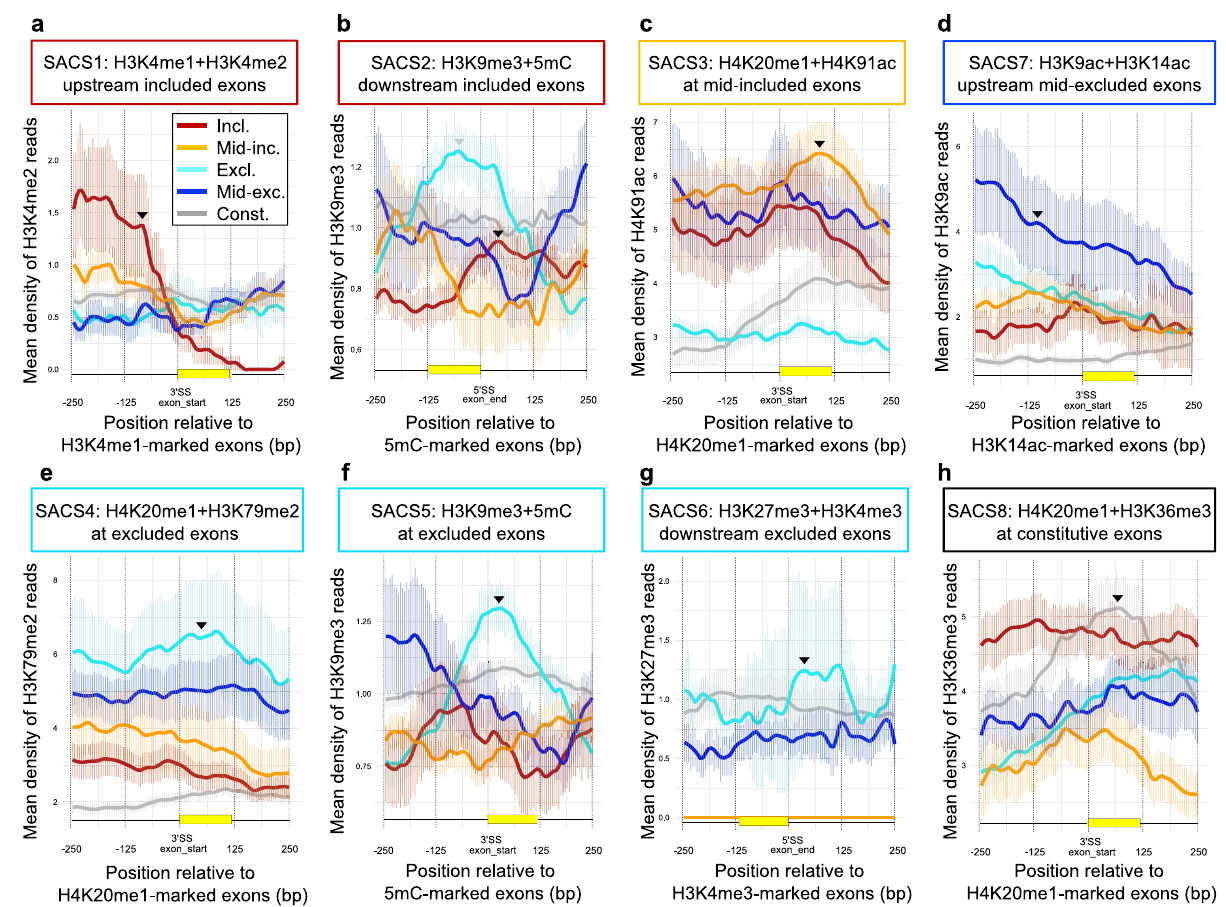
Fig. 3 Pro fi les of Splicing-associated Chromatin Signature (SACS). a Density pro fi les of H3K4me2 reads around exons marked by H3K4me1 upstream the 3 ’ ss exon start. b H3K9me3 reads around exons marked by 5mC downstream the 5 ’ ss end of the exon. c H4K91ac reads around H4K20me1-marked exons. d H3K9ac reads around exons marked by H3K14ac upstream the exon start. e H3K79me2 reads around H4K20me1-marked exons. f H3K9me3 reads around 5mC-marked exons. g H3K27me3 reads around exons marked by H3K4me3 downstream the end of the exon. h H3K36me3 reads around H4K20me1-marked exons in excluded (excl., light blue), mid-excluded (mid-exc., dark blue), mid-included (mid-inc., yellow), included (incl., red) and constitutive (const., grey) exons using available ChIP-seq datasets from H1 hESCs. The average read count and ±SEM of histone marks ’ reads is represented ±250 bp from either the 5 ′ or 3 ′ splice site (ss), depending on the SACS. For each mark, we highlight with a black arrow the splicing group that is the highest enriched at a speci fi c position around the regulated exon, as de fi ned by the SACS. Please notice that H3K9me3 + 5mC is enriched at both included (SACS2) and excluded (SACS5) exons but at different positions, this is why there are two arrows (in grey the enrichment that corresponds to the other